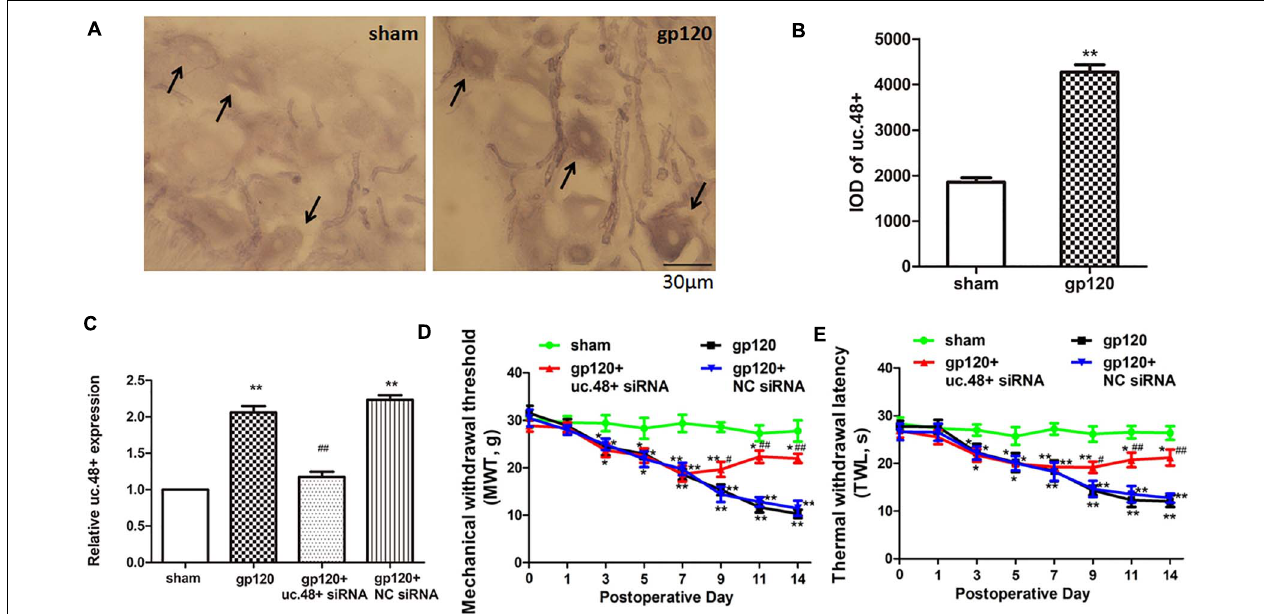
FIGURE 2 | LncRNA uc.48+ was involved in gp120-induced neuroinflammatory pain. (A) Uc.48+ was expressed in cytoplasm of DRG neurons (scale bar: 30 µ m). (B) ISH showed uc.48+ expression in gp120 rats was markedly higher. (C) Real-time PCR results showed that uc.48+ siRNA downregulated expression of uc.48+. (D,E) After treatment with siRNA targeting uc.48+, MWT (D) and TWL (E) in gp120-treated rats were alleviated. n = 10 rats per group. Data are displayed as means ± SEM. ∗ p < 0.05, ∗∗ p < 0.01 vs. sham group, # p < 0.05, ## p < 0.01 vs. gp120 group.